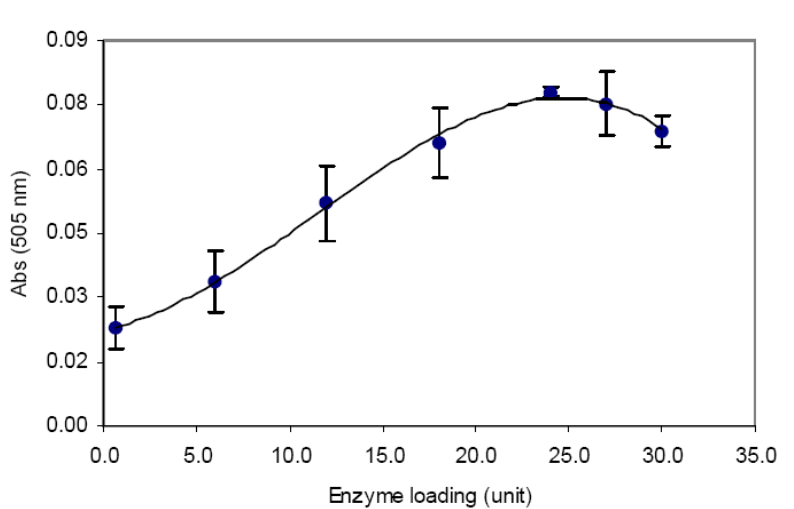
Figure 8 . The changes of the activity of laccase immobilized in a chitosan film as a function of enzyme